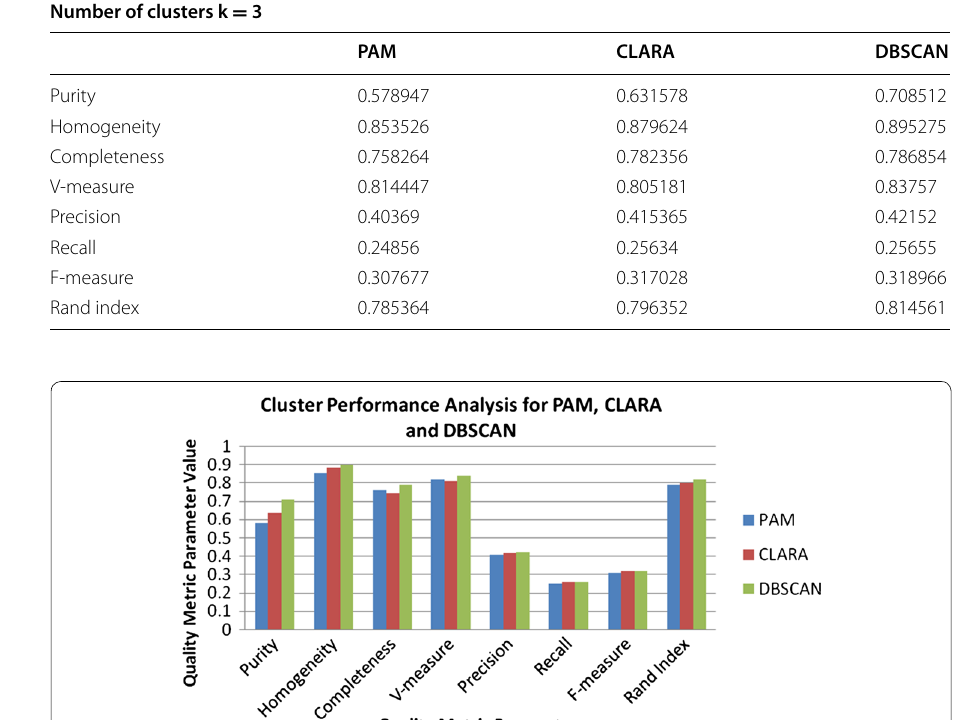
Table 6 Comparison of clustering methods